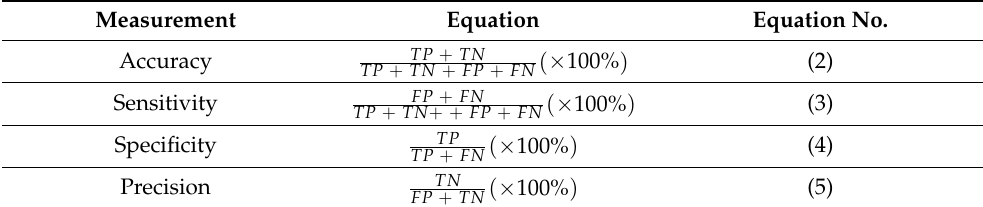
Table 3. Performance measurement metrics.